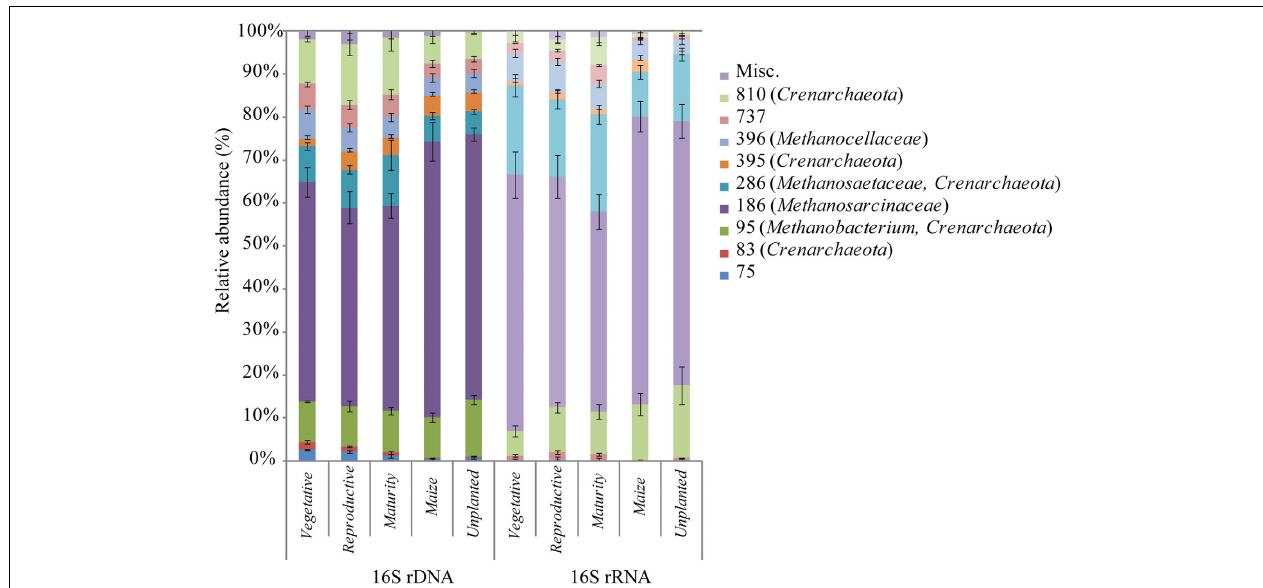
FIGURE 4 | Histograms of the relative abundance of T-RFs obtained from T-RFLP analysis of archaeal 16S rDNA and rRNA during rice plant growth. Terminal restriction fragment sizes and affiliated clone taxonomy are given in brackets. Bars represent standard errors of n = 9.